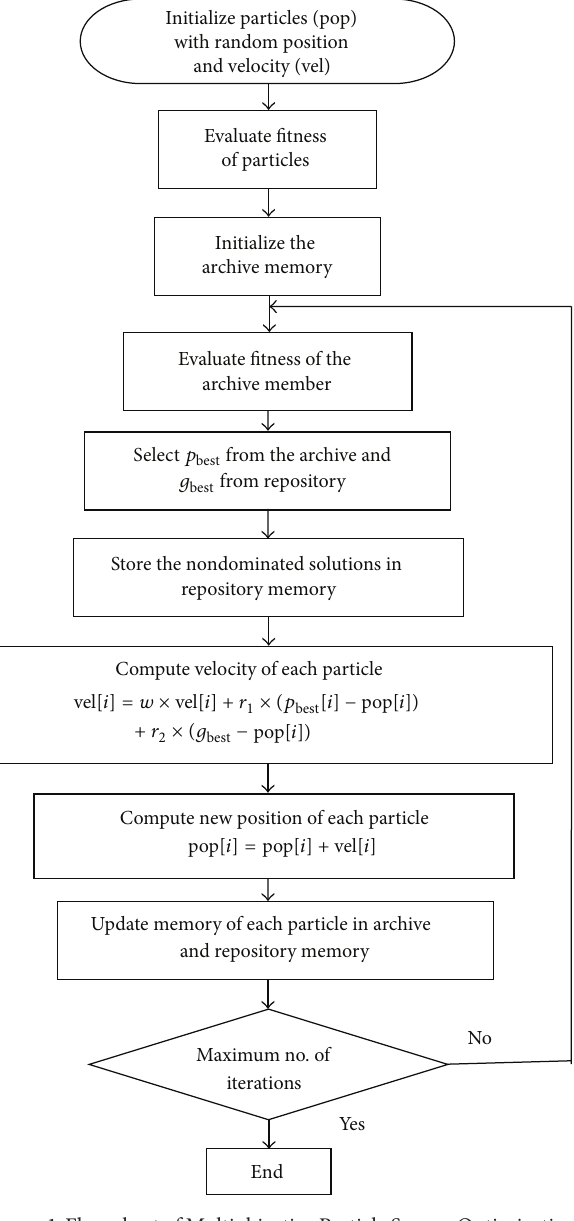
Figure 1: Flow chart of Multiobjective Particle Swarm Optimization algorithm.